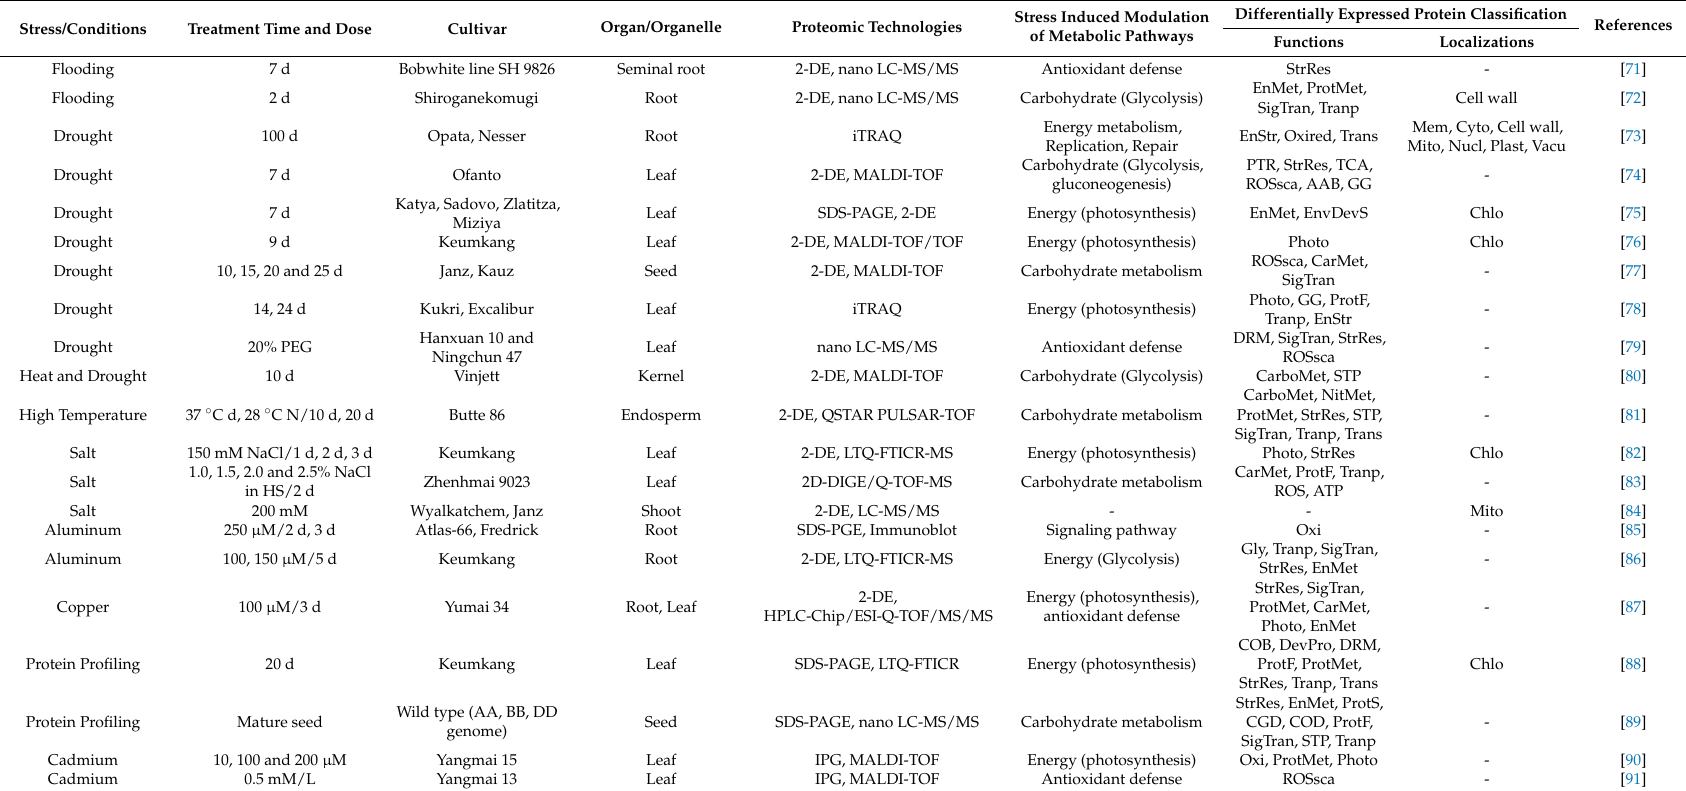
Table 2. A list of wheat proteomics studies focused on response to abiotic stresses and